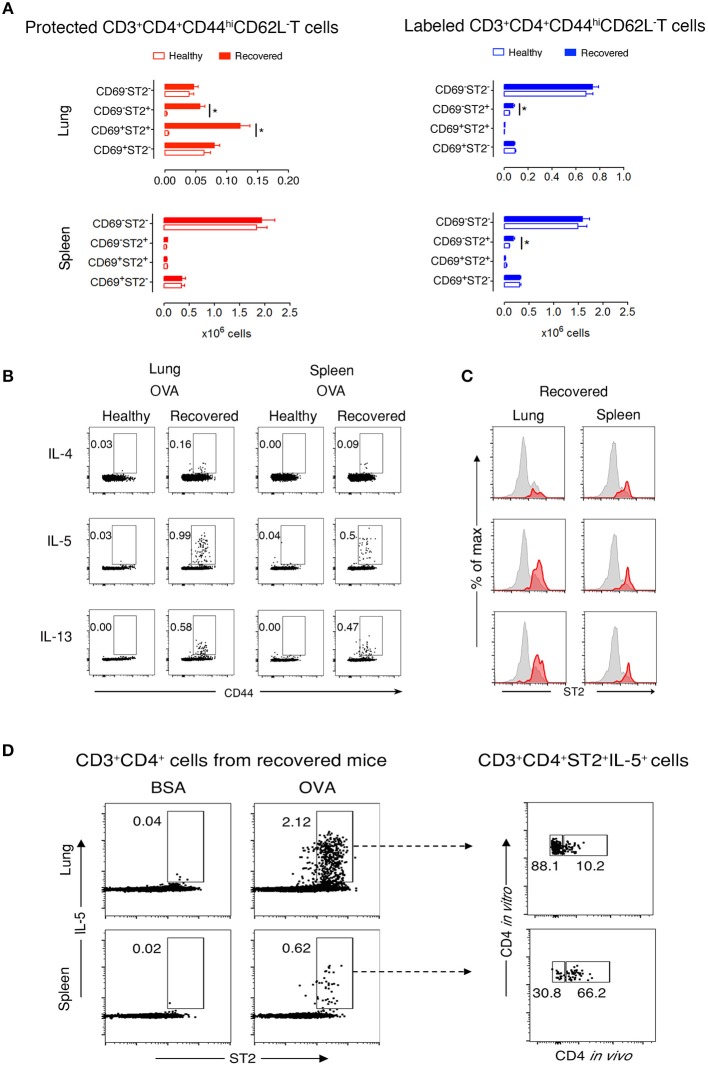
Protected allergen-specific lung CD3+CD4+ T cells express CD69 and ST2. (A) Absolute numbers of protected and labeled CD3+CD4+CD44hiCD62L− T cells differing in CD69 and ST2 expression in lungs and spleens of mice after an average of 199 days (range from D164-244) of recovery and age-matched healthy controls. Data are shown as mean ± SEM of 12 mice/time point and were compiled from three independent experiments. *p < 0.05 using two-way ANOVA. (B) Representative dot-plots indicating that allergen-specific Th2 cells are present in lungs and spleens of recovered mice. At D227, lung and spleen cells from healthy and recovered mice (n = 3) were isolated, pooled, and stimulated for 9 h with OVA-loaded peritoneal macrophages. Dot-plots show CD44 vs. intracellular IL-4, IL-5, or IL-13 on gated CD3+CD4+ cells. Numbers indicate the percentage of cells in the respective cytokine-producing gate. Data are representative of three independent experiments. (C) Histograms show ST2 expression on total CD3+CD4+CD44hi T cells (gray) and IL-4-, IL-5-, or IL-13-producing CD3+CD4+CD44hi T cells (red) in lungs and spleens of recovered mice (n = 3) at D227. Data are representative of three independent experiments. (D) Lung and spleen cells from recovered mice (n = 3) at D227 were isolated 10–15 min after i.v. anti-CD4 mAb administration, pooled, and stimulated for 9 h with BSA- or OVA-loaded peritoneal macrophages. Dot-plots on the left side show ST2 vs. intracellular IL-5 on gated CD3+CD4+ cells. Dot plots on the right side indicate that the majority of IL-5 producing OVA-specific CD3+CD4+ ST2+cells in the lung, but not in the spleen, are protected from in vivo antibody labeling. Numbers indicate the percentage of cells in the respective cytokine-producing gate. Data are representative of three independent experiments.